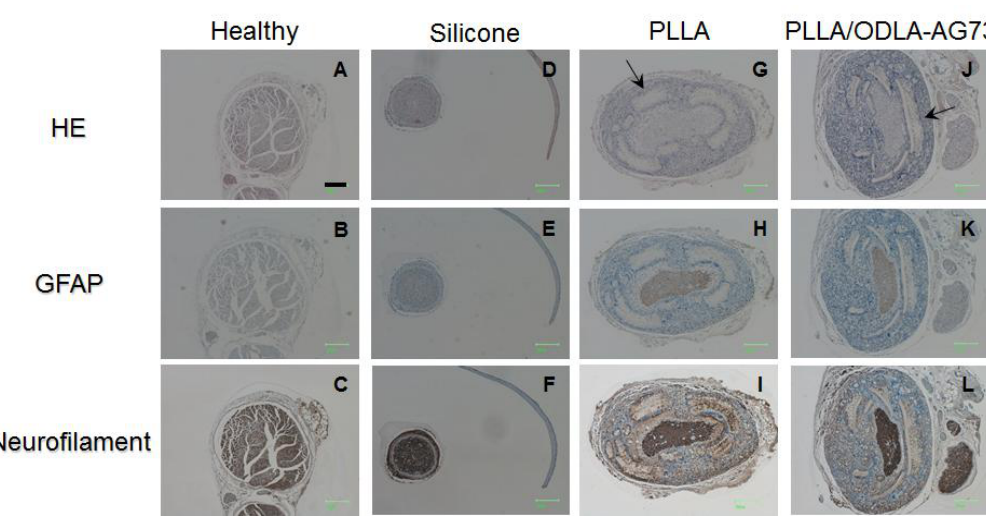
Figure 5. Immunohistochemical analysis of axial cross sections of implanted silicone tube (used as a control), PLLA conduit, and PLLA/ODLA-AG73 conduit around a distal connection six months after implantation, with different stains applied: ( A , D , G , J ) HE stain; ( B , E , H , K ) GFAP-positive cells (brown); ( C , F , I , L ) Neurofilament (brown). Note the conduit fragments (indicated by arrows) (Scale bar = 200 